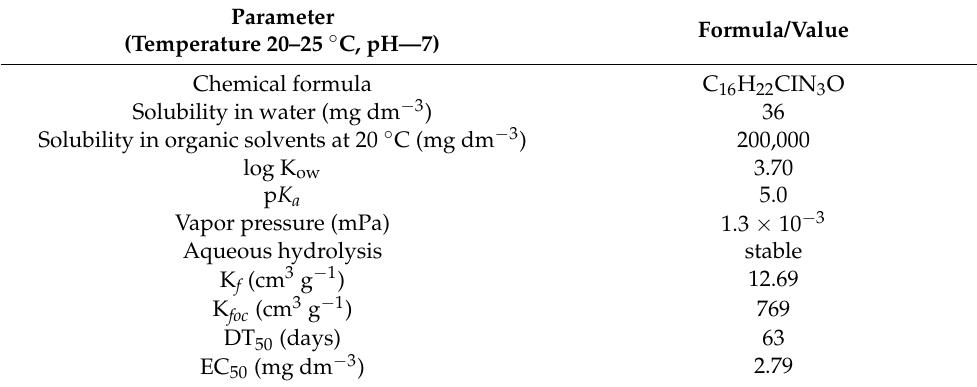
Table 4. Selected physicochemical properties of tebuconazole